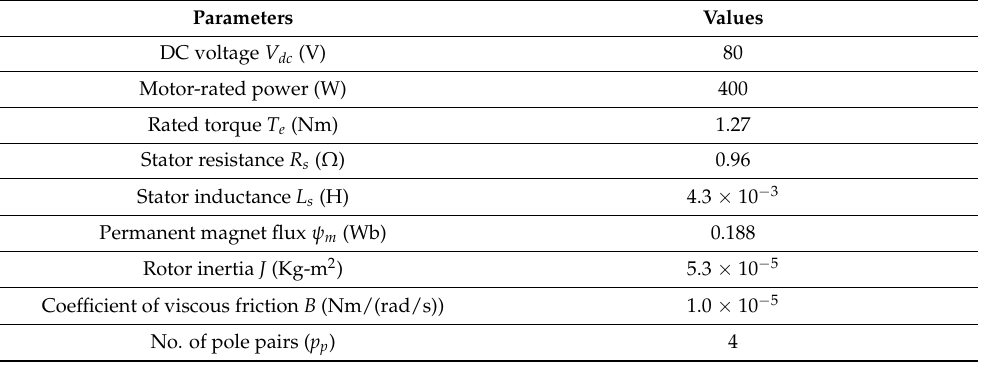
Table 2. System parameters.